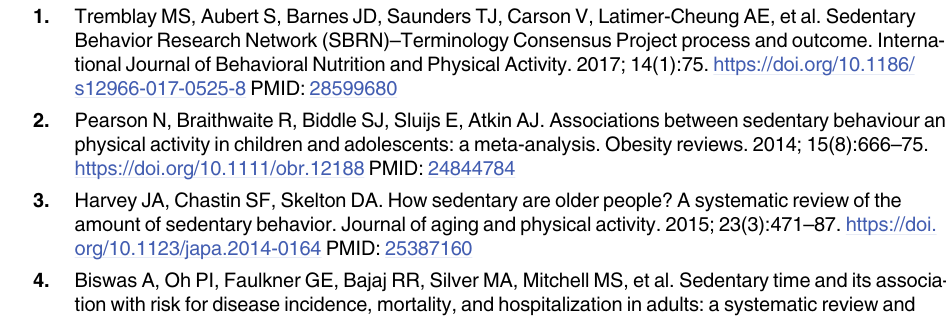
S1 Table. Questions used to assess self-reported diagnosis. S2 Table. Questions and answer options used for symptoms-based diagnosis. S3 Table. Questions used to assess health